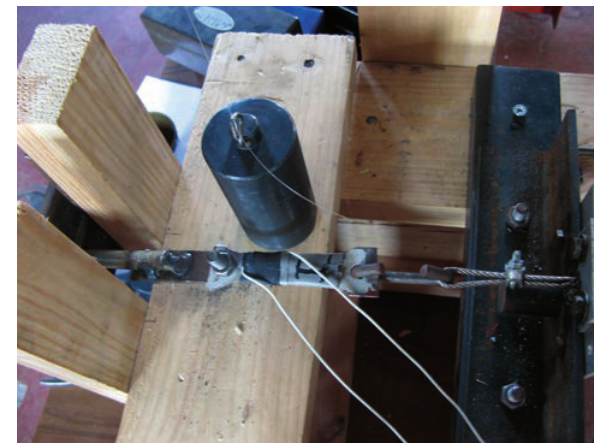
Fig. 10. Strain gauges to measure the elongation of the cables